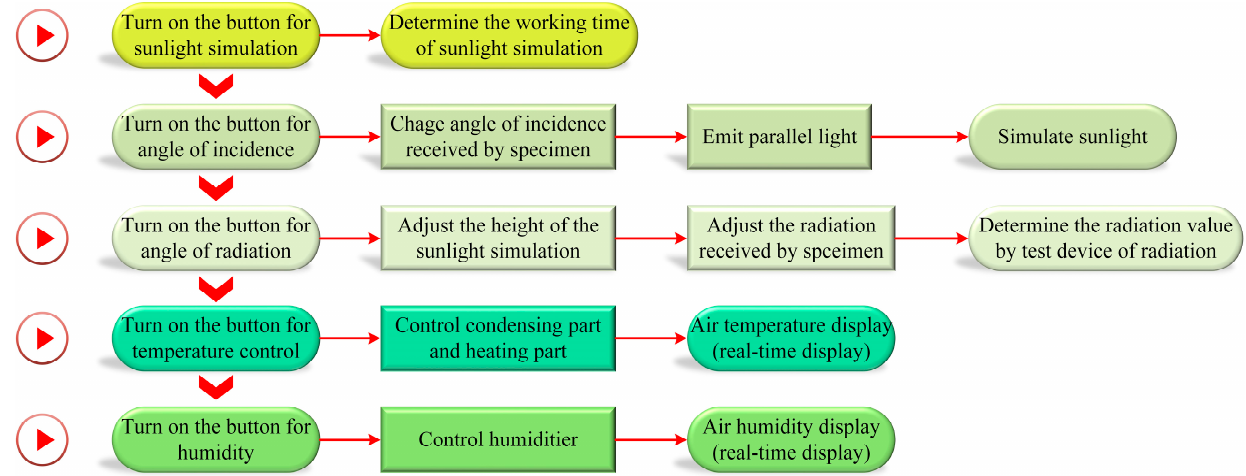
Figure 7. The process of setting